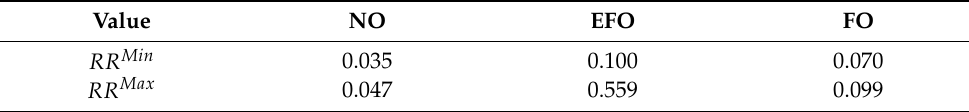
Figure 13. RMS sound values for NO, EFO, and FO of the IVT. Table 4. List of reference ranges RR for NO, EFO, and FO of the